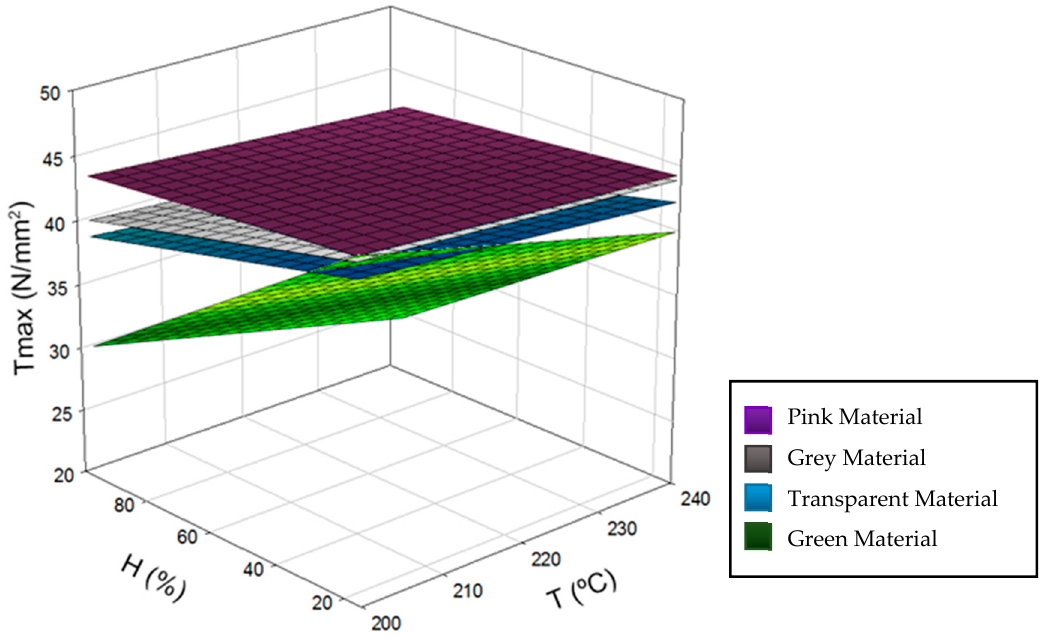
Figure 6. Plot of tensile strength (Tmax) trends as function of variable temperature (T) and relative humidity (H).